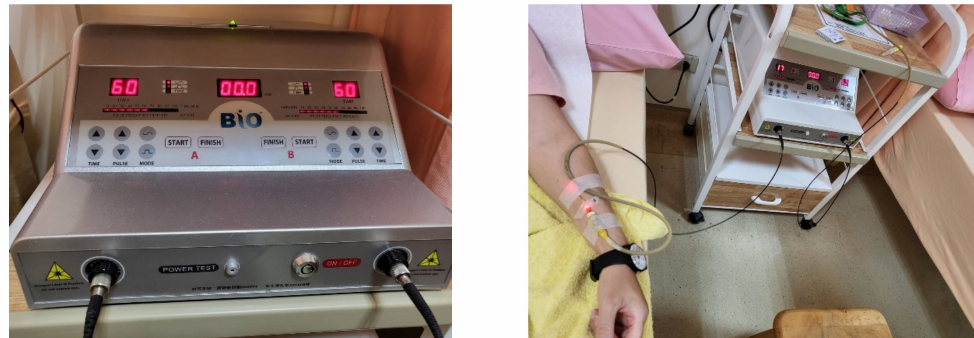
Figure 1. ILIB equipment (Left) and settings during ILIB treatment (Right).